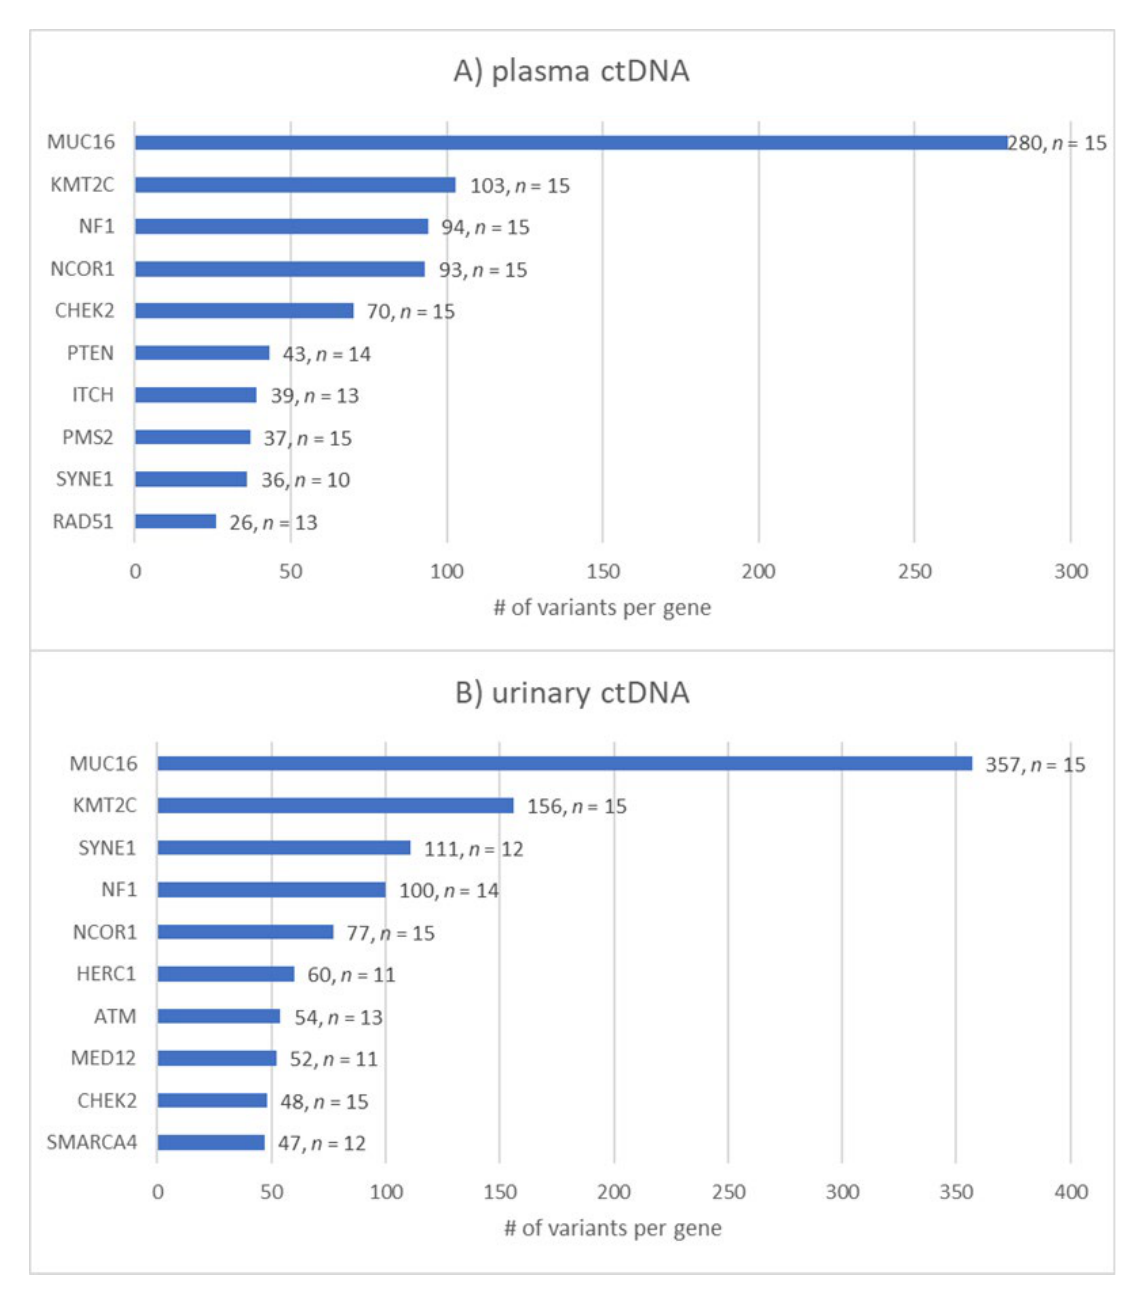
Figure 6. The top 10 most frequently mutated breast-cancer-associated genes in ( A ) plasma and ( B ) urinary ctDNA. Bar chart showing the number of variants found for the top 10 genes and the number of samples ( n of 15) in which the gene was altered. MUC16 and KMT2C are by far the most altered genes in both ctDNA sources followed by NF1 in plasma and SYNE1 in urinary ctDNA.